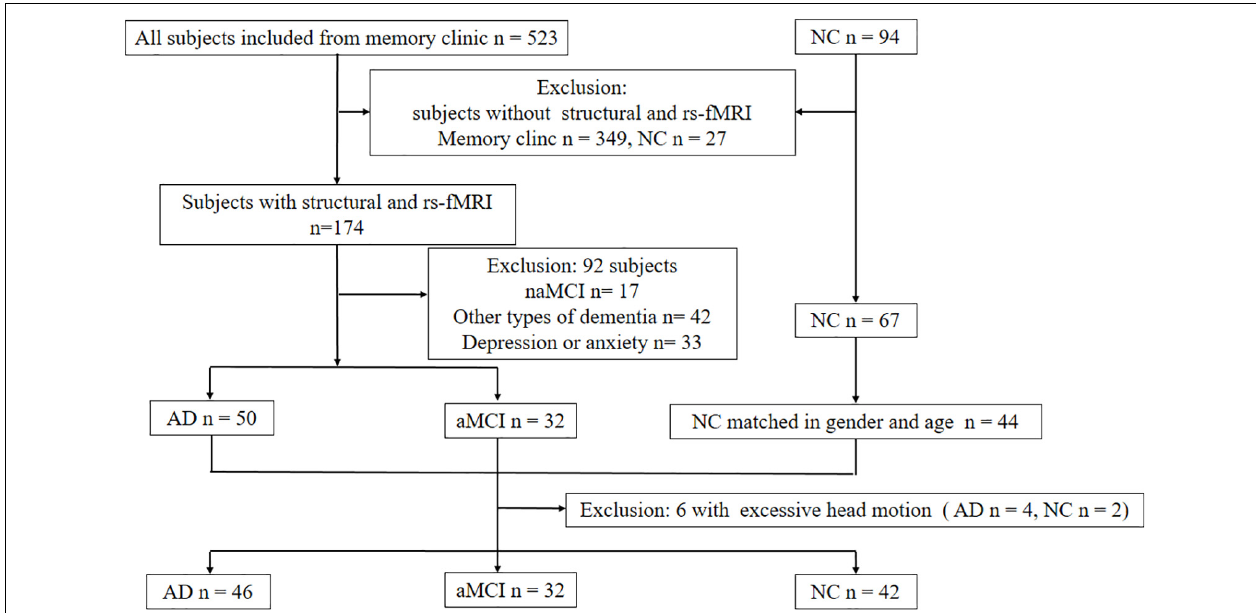
FIGURE 2 | Diagram showing the number and flow of subjects in this study. Abbreviations: NC: normal control; aMCI: amnestic mild cognitive impairment; naMCI: non-amnestic mild cognitive impairment; rs-fMRI: resting-state functional MRI.